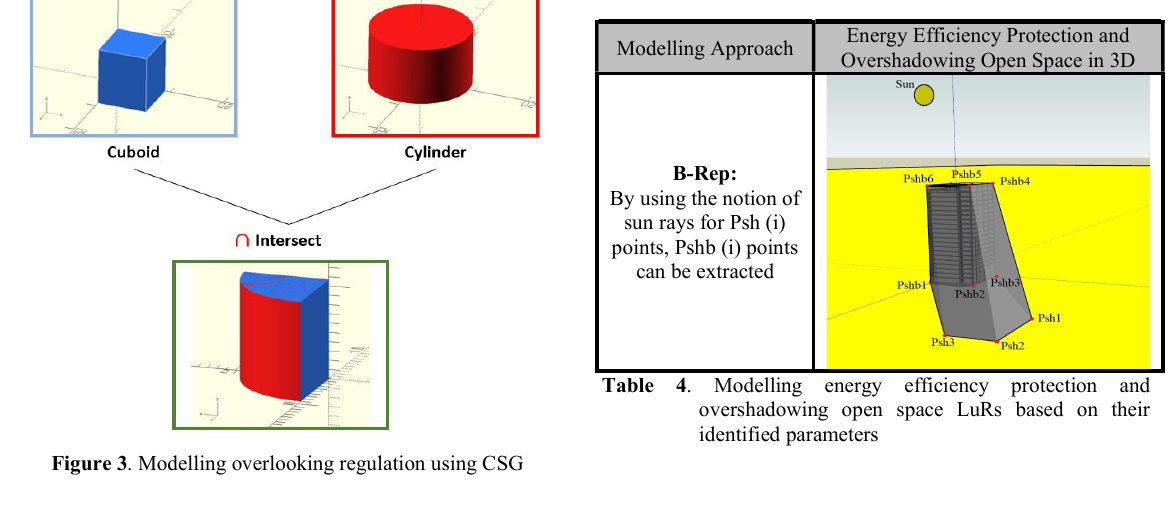
Table 3 . Modelling building height LuR based on its identified parameters For energy efficiency protection and overshadowing open space regulations, since their 3D extents vary based on the geometric shape and size of the proposed building, we propose to model it by using the B-Rep approach based on the identified parameters (i.e. Psh (i) and Pshb (i)). Table 4 shows energy efficiency protection and overshadowing open space regulations in 3D notion of sun rays are discussed.